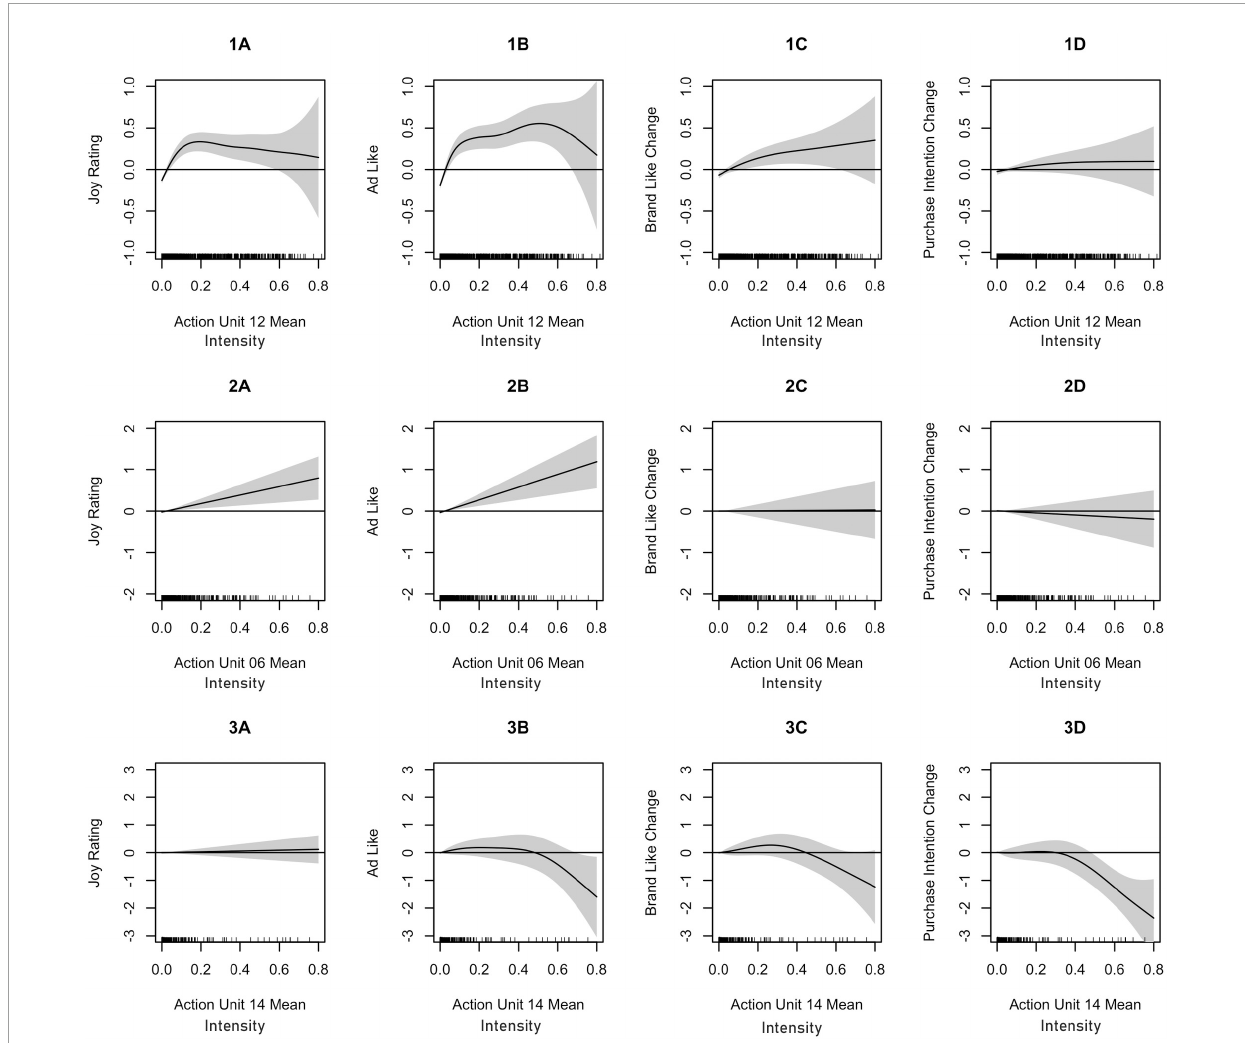
FIGURE2 Fitted smooth main effects model for Action Unit means of AU12 [lip corner pull, (1A–1D) ], AU06 [cheek raiser, (2A–2D) ], and AU14 [dimpler, (3A–3D) ]. The graphs show the estimated marginal effects on joy ratings (1A–3A) , advertisement likeability (1B–3B) , brand likeability change (1C–3C) , and purchase intention change (1D–3D) . The effects are centered around zero. The shaded areas show 95% pointwise confidence